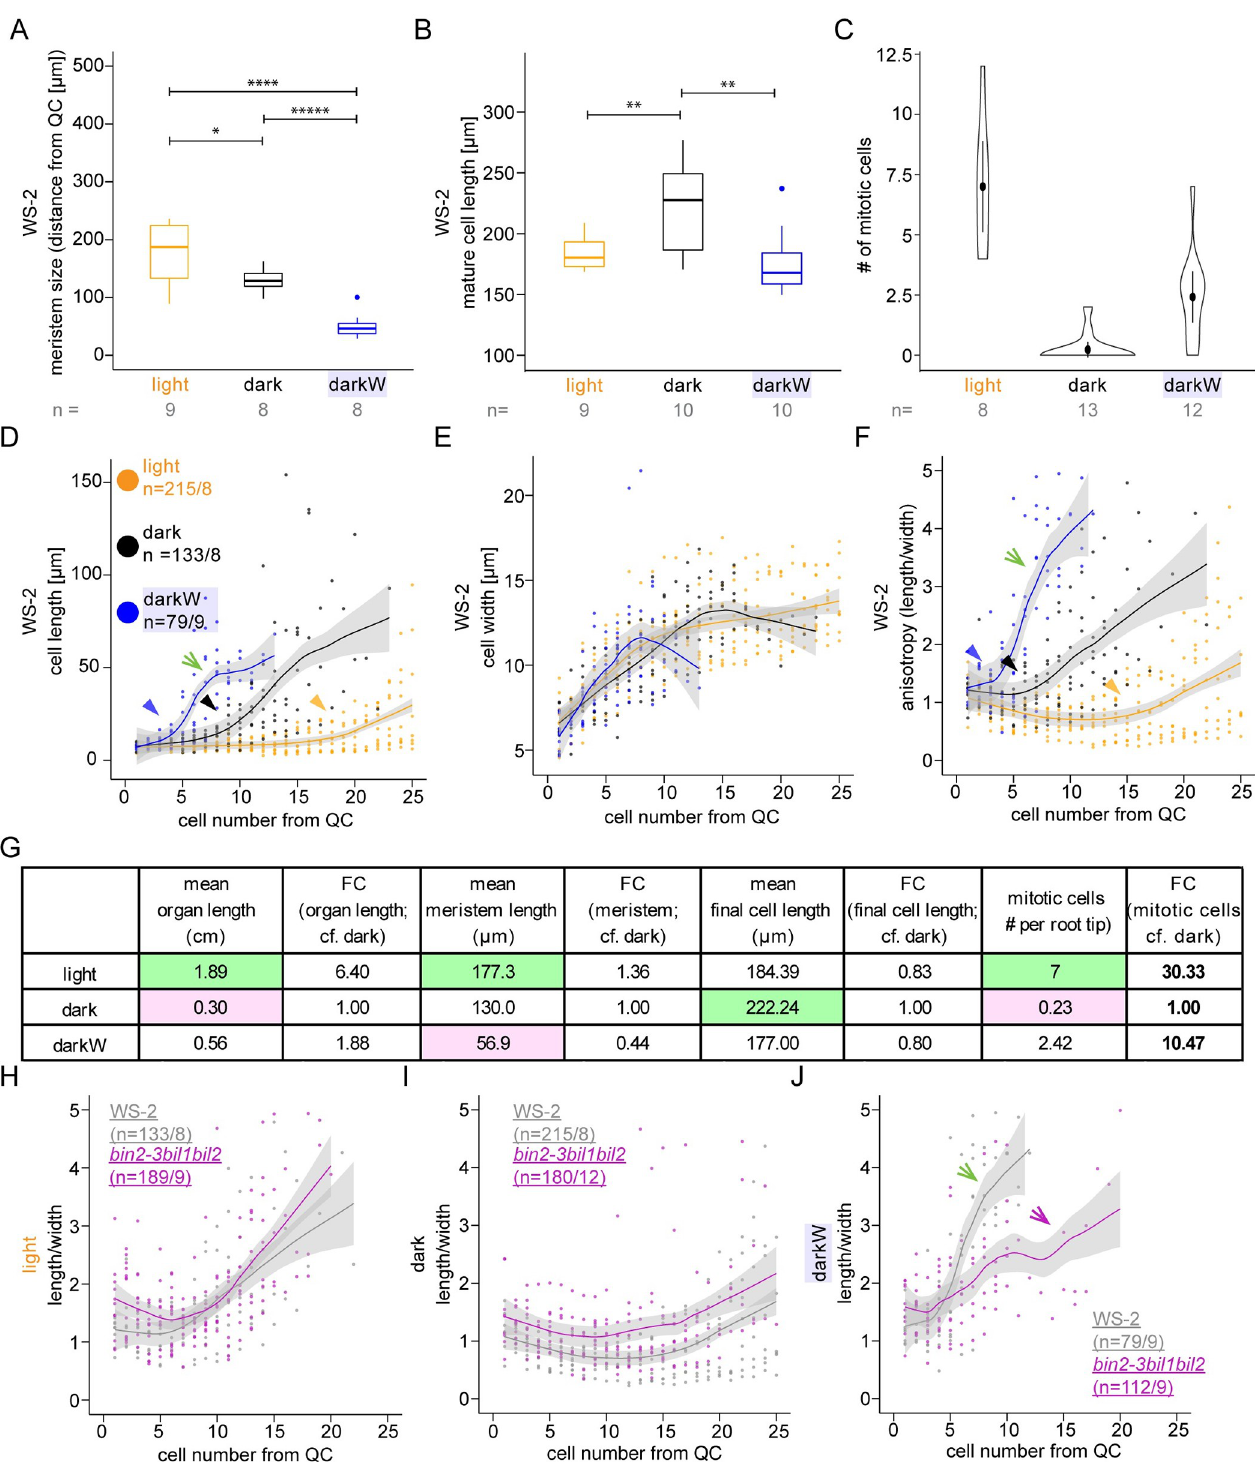
Fig 6. Root meristem properties under single versus multiple stress conditions. Seedlings were grown in the light (orange), dark (black) or dark with -0.4MPa water stress (blue). (A-F) Wild type, with ecotype specified in the panel. (A) Meristem size determined via mixed Gaussian models, as described ([43]; S14 Fig ). (B) Mature cell length, based on the ten most elongated cells for each condition; similar conclusions were reached when the 50 longest cells were used. (C) mitotic index at day 7 based on CycB1,1:GUS ([44]; S15C and S15D Fig ). (D-F and H-J) 10 days after incubation, single epidermal cell files were measured, starting at the epidermal/ lateral root cap initials. The fitted lines were generated with Local Polynomial Regression Fitting with the ‘loess’ method in R; grey